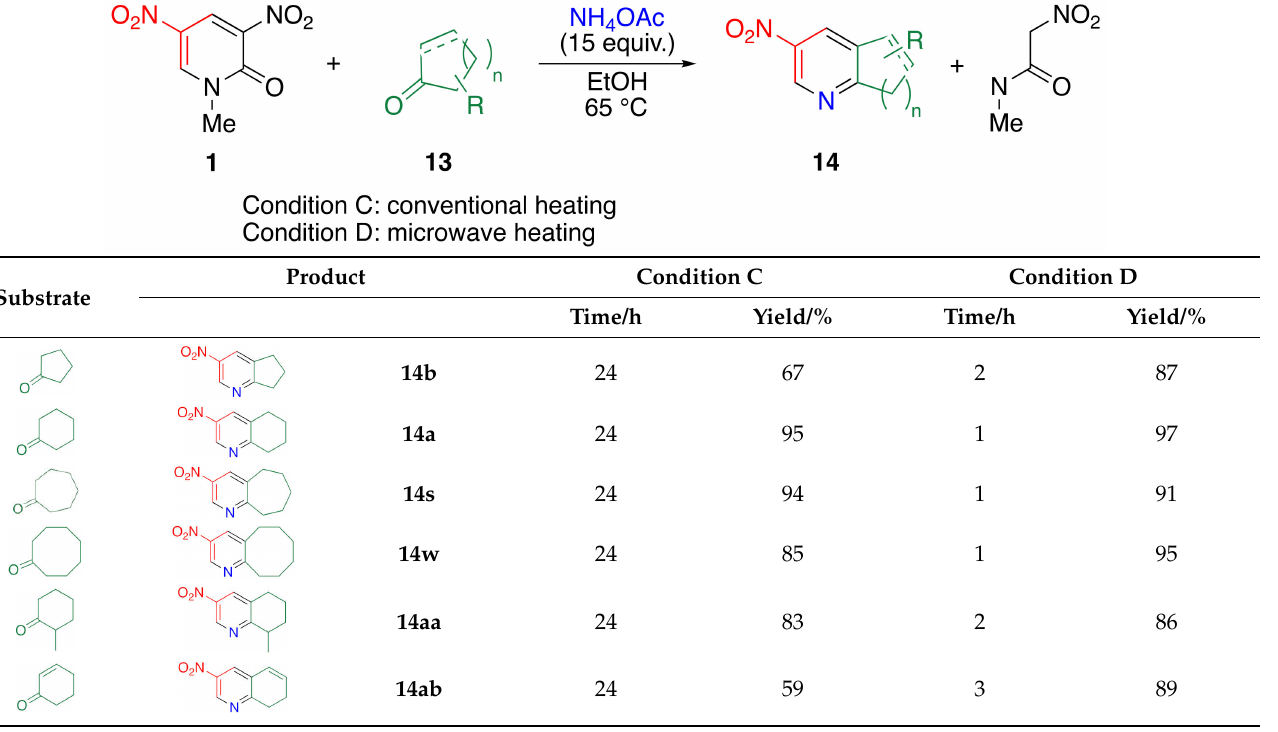
Table 8. TCRT with cycloalkanones 13